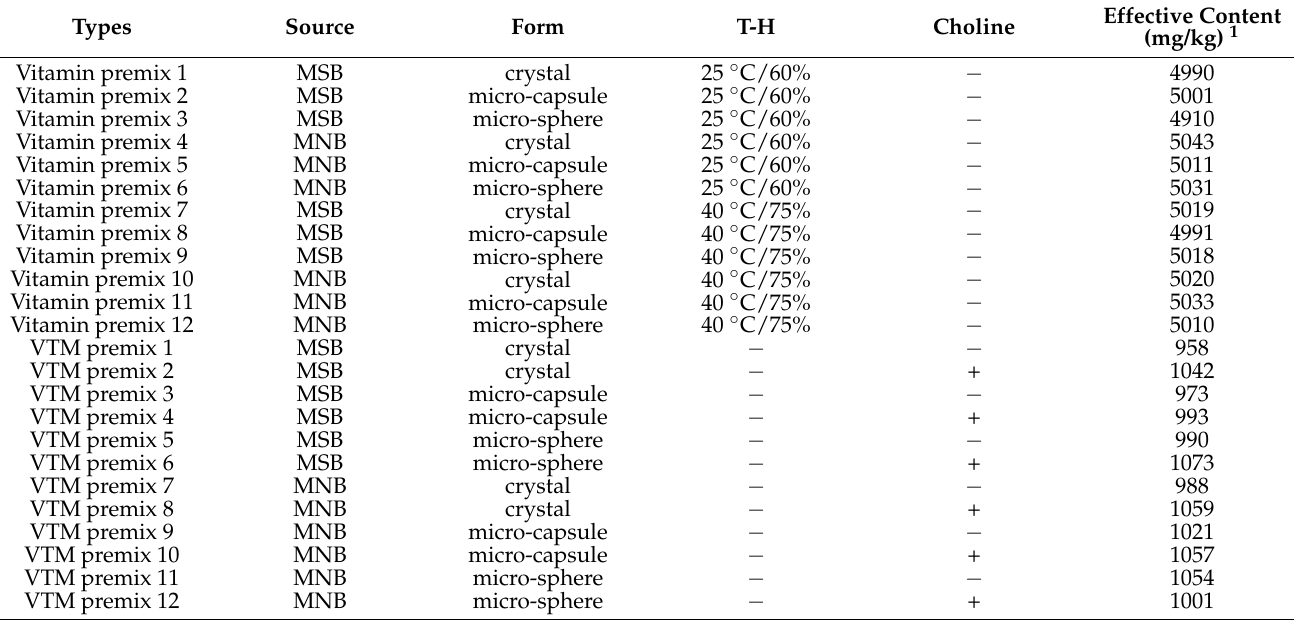
Table 2. Analyzed vitamin K 3 values in vitamin and vitamin vitamin-trace mineral (VTM) premixes.